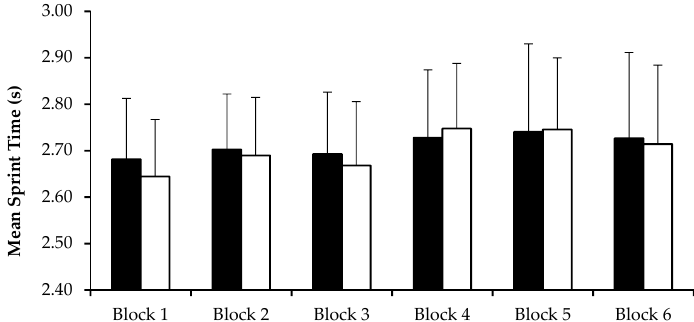
Figure 2. Mean sprint times for the six blocks of the LIST during CHO ( ■ ) and PLA ( □ ) trials. LIST: Loughborough Intermittent Shuttle Test; CHO: carbohydrate trial; PLA: placebo trial. The self ‐ selected distance covered and mean speed for blocks 3 and 6 of the LIST during the CHO and PLA trials are displayed in Table 1. There were no differences in total distance covered ( p = 0.122) or mean speed ( p = 0.070) between CHO or PLA trials. There was a main effect of time for total distance covered ( p = 0.011) and mean speed ( p = 0.005), with more distance covered and faster